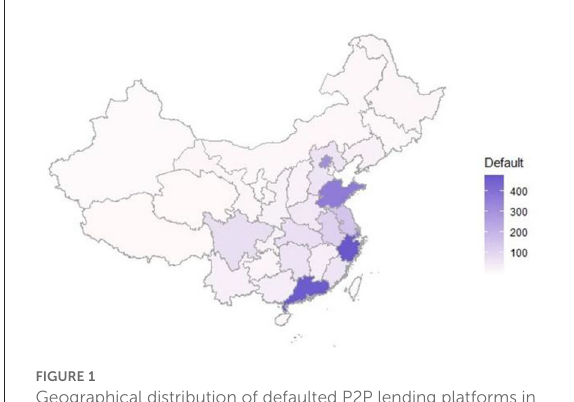
FIGURE1 Geographical distribution of defaulted P2P lending platforms in